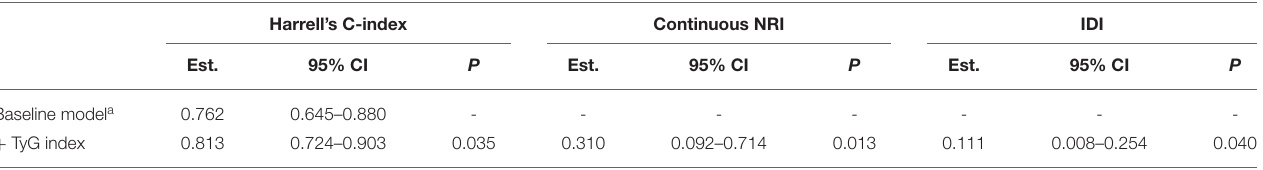
TABLE 5 | Incremental effect of TyG index on the prediction of in-hospital